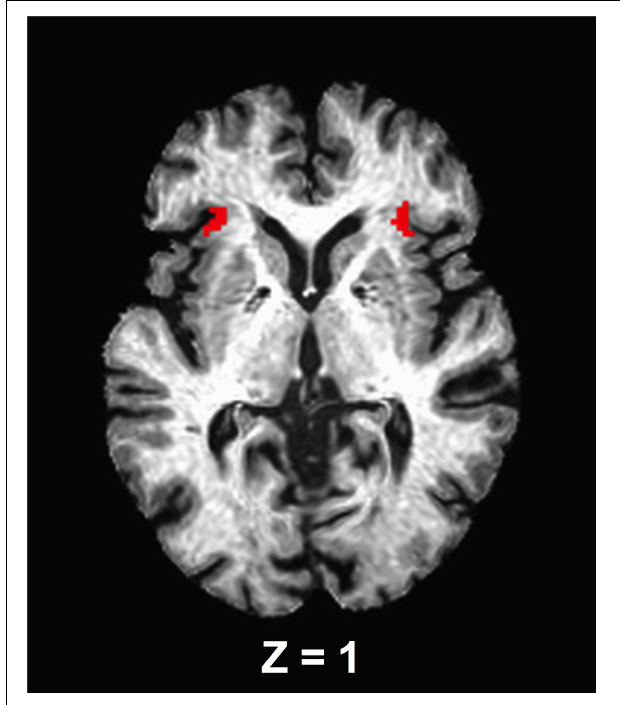
FIGURE 1 | An axial view of the anterior insula seed regions. The seed masks are exhibited on a representative subject’s structural